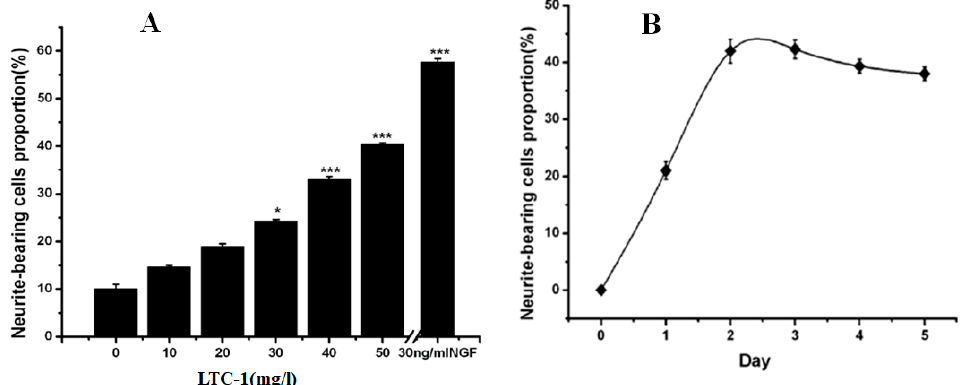
Figure 4. LTC-1 promotes the growth of PC12 cell neurites. ( A ) The relationship between LTC-1 promotion of PC12 cell neurite growth and concentration; ( B ) The relationship between LTC-1 promotion of PC12 cell neurite growth and time. The control group was defined as the group that received only NGF (1 mg/L). The neurite lengths of PC12 cells were measured after 4 days. The data are presented as the mean ± SD (n = 100). One-way ANOVA was used for statistical analysis, followed by Tukey’s multiple comparison test, * p < 0.05, *** p < 0.001 vs. control.